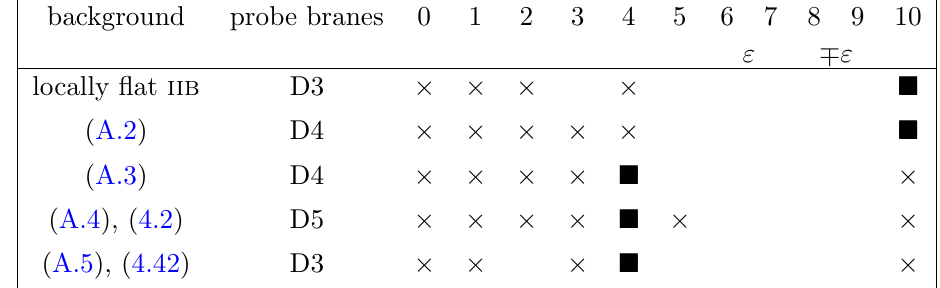
Table 4 . Probe branes and their backgrounds. A black square (cid:4) means that the direction is not part of the ten-dimensional geometric